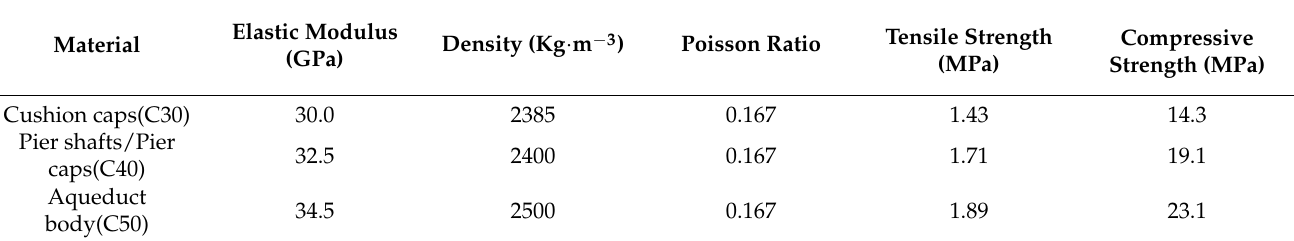
Figure 2. Aqueduct structure model. ( a ) Numerical model of the aqueduct structure; ( b ) Aqueduct structure details. a, b, c, and d are feature points of damage. Table 1. Various material parameters of the